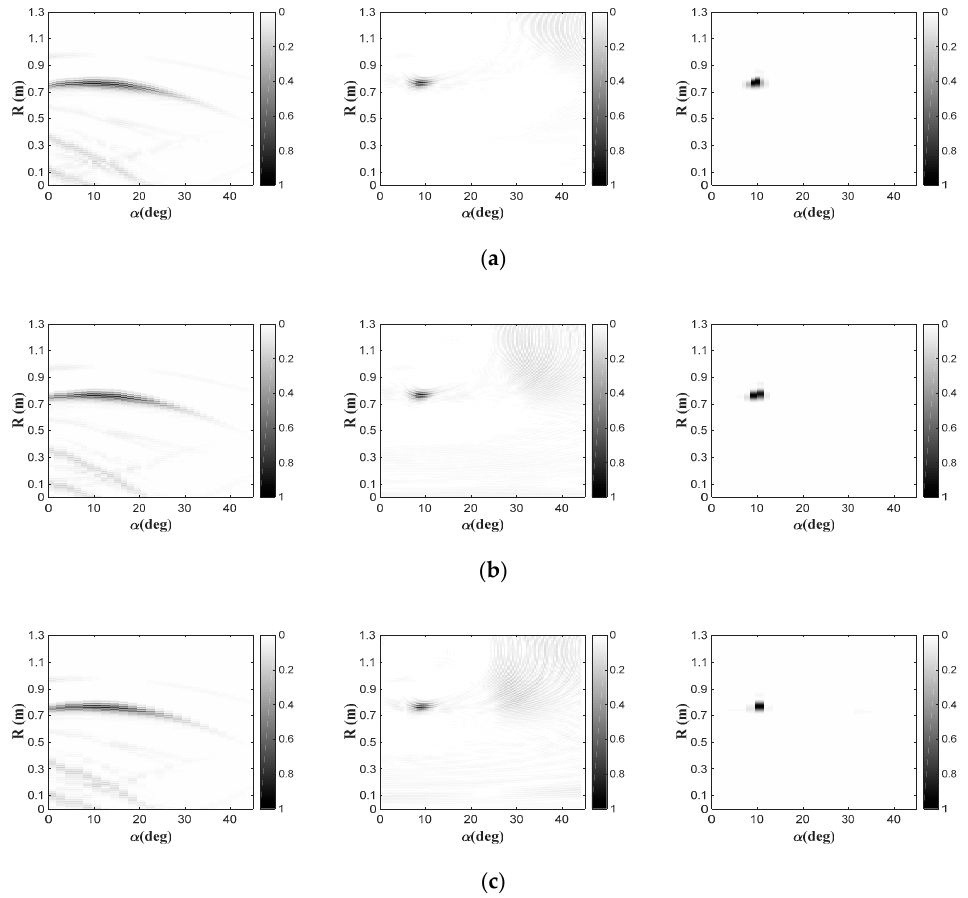
Figure 11. Comparisons of the results by the B-scan ( Left ), DAS ( Middle ), and CSAFT ( Right ) methods for different angular steps: ( a ) θ s = 1 ◦ ; ( b ) θ s = 1.5 ◦ ; ( c ) θ s = 2.0 ◦ . The excitation signal is a tone-burst signal with three cycles.